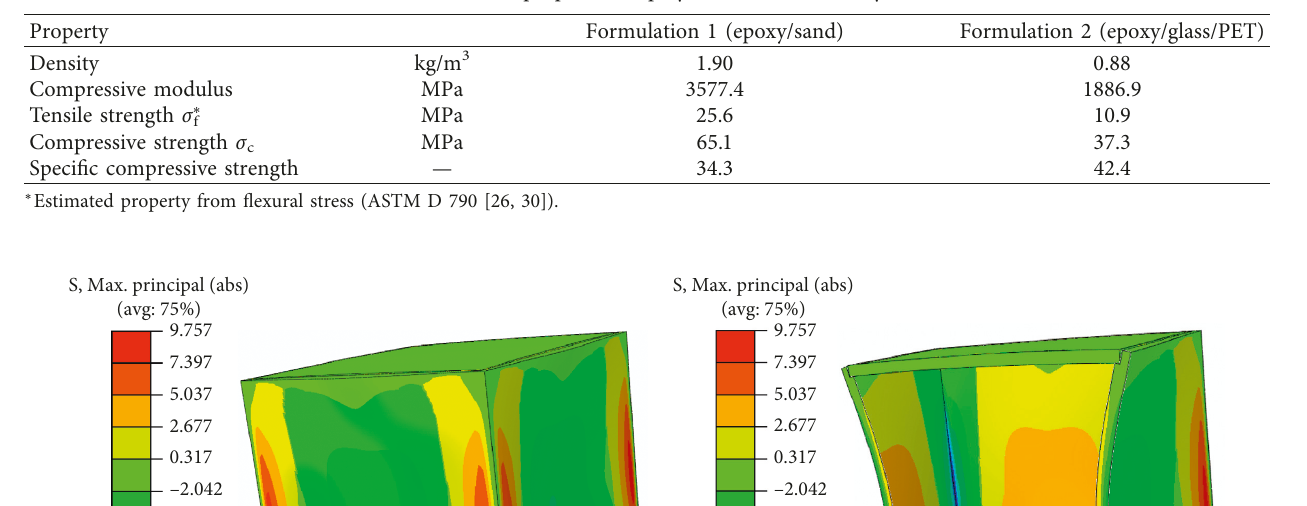
Table 5: Material properties of polymer concrete (PC) systems.